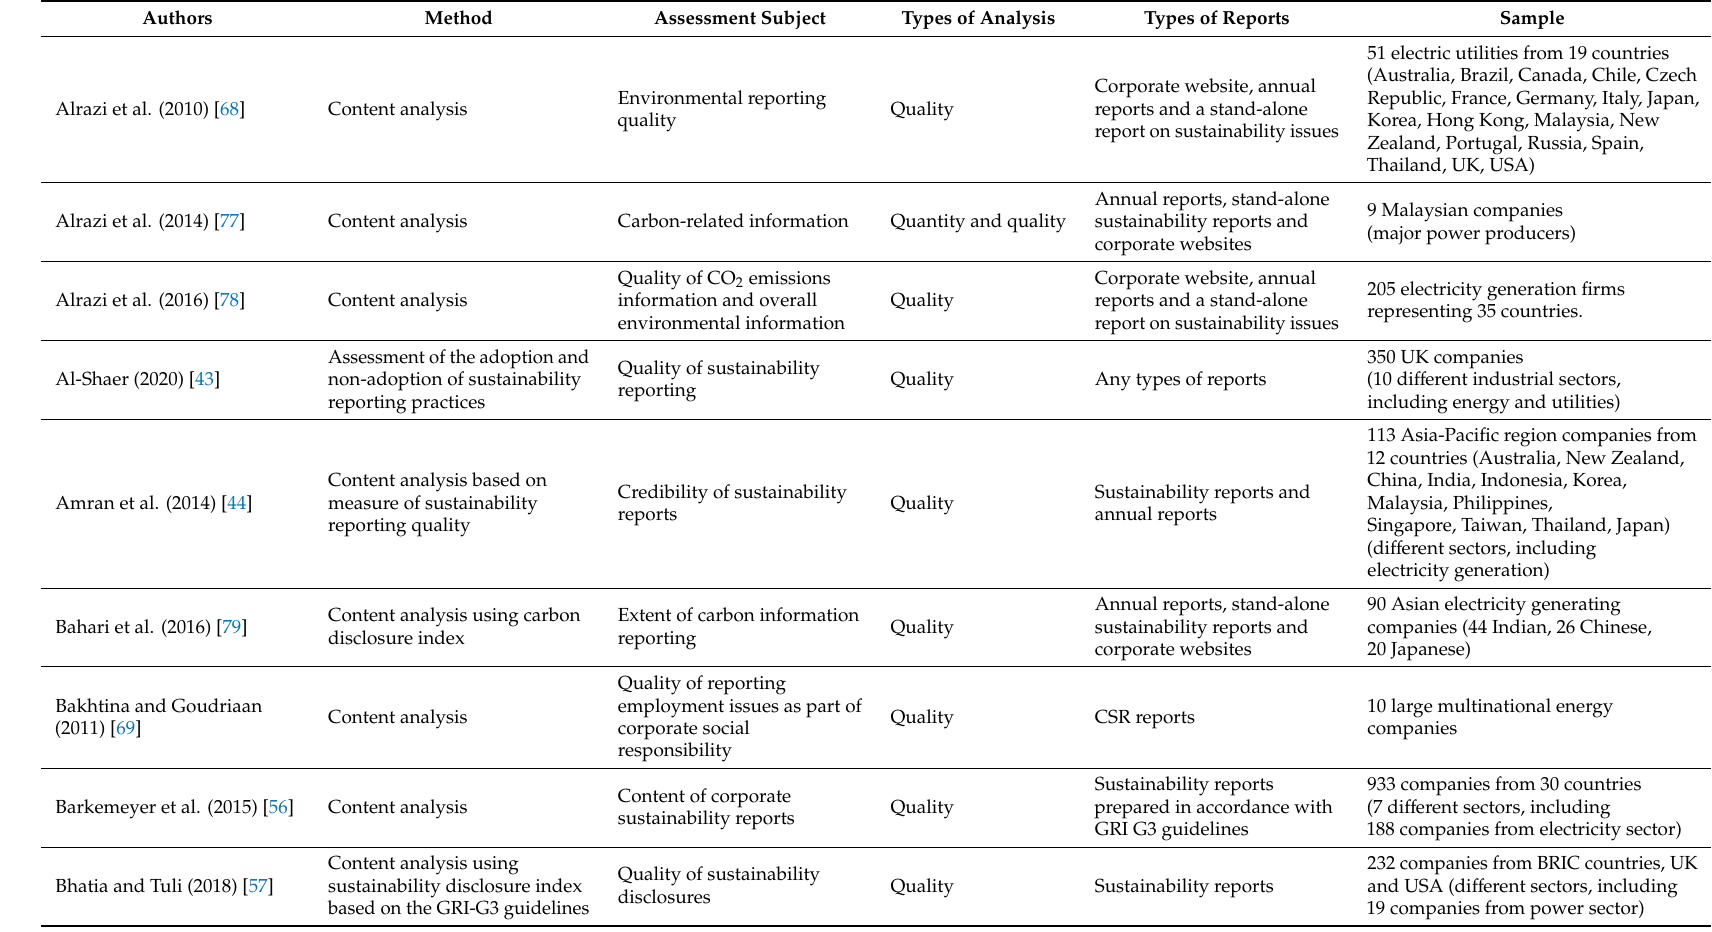
Table A1. Overview of research on the sustainability reports assessment in the energy